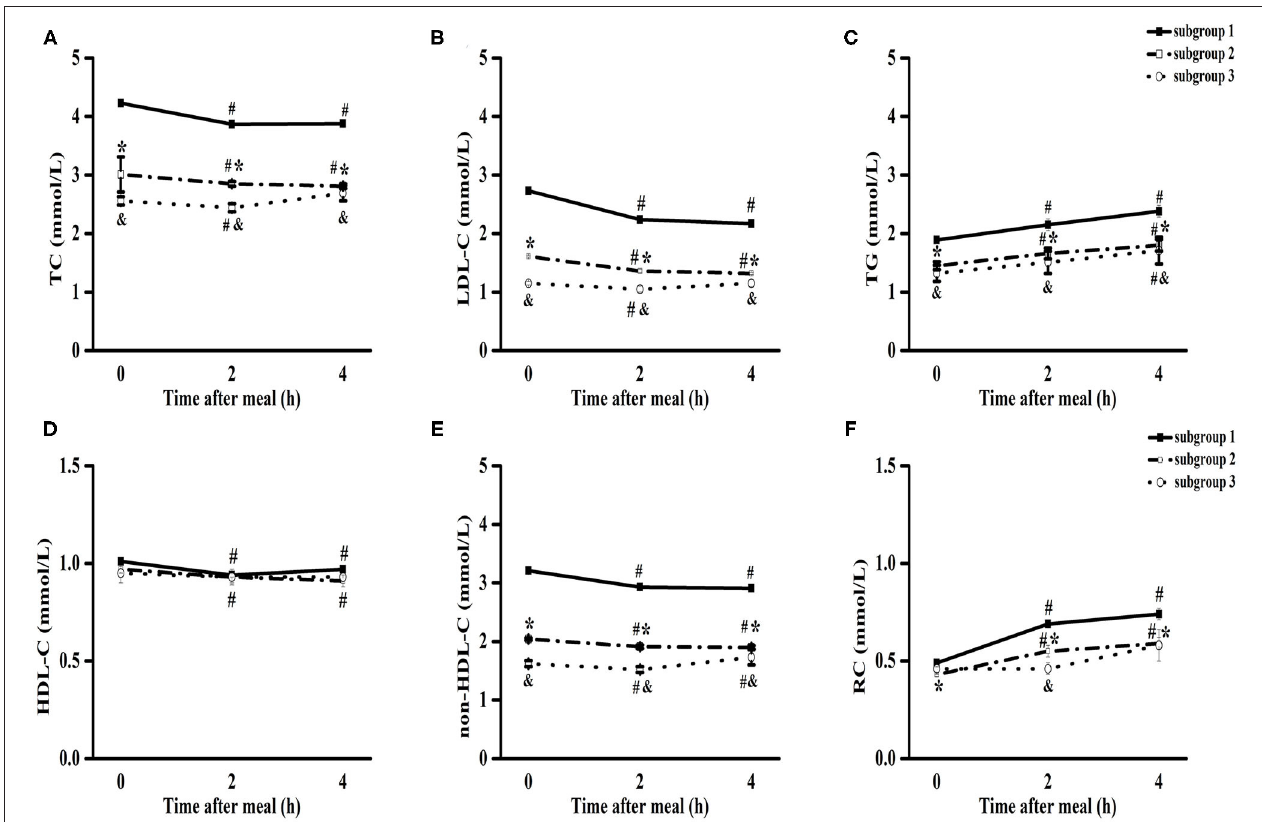
FIGURE 2 | Comparisons of the blood lipids levels among three subgroups of patients with CHD after a daily breakfast. Comparisons of TC (A) , LDL-C (B) , TG (C) , HDL-C (D) , non-HDL-C (E) and RC (F) levels among three subgroups after a daily breakfast. # P < 0.05 when compared with fasting value within the same subgroup, * P < 0.05 when the subgroup 2 compared with the subgroup 1 at the same time point, & P < 0.05 when the subgroup 3 compared with the subgroup 1 at the same time point, # in (D) meant non-fasting HDL-C values were significantly lower than those of fasting values in subgroup 1 and subgroup